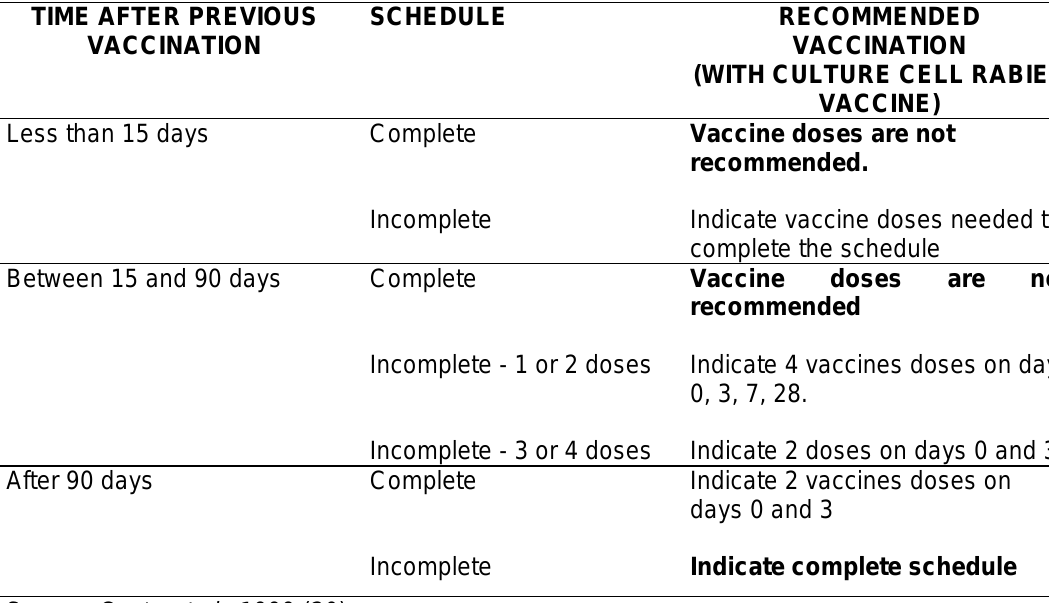
(WITH CULTURE CELL RABIES VACCINE) Vaccine doses are not recommended. Indicate vaccine doses needed to complete the schedule Vaccine doses are not recommended Indicate 4 vaccines doses on day 0, 3, 7, 28. Indicate 2 doses on days 0 and 3. Indicate 2 vaccines doses on days 0 and 3 Indicate complete schedule